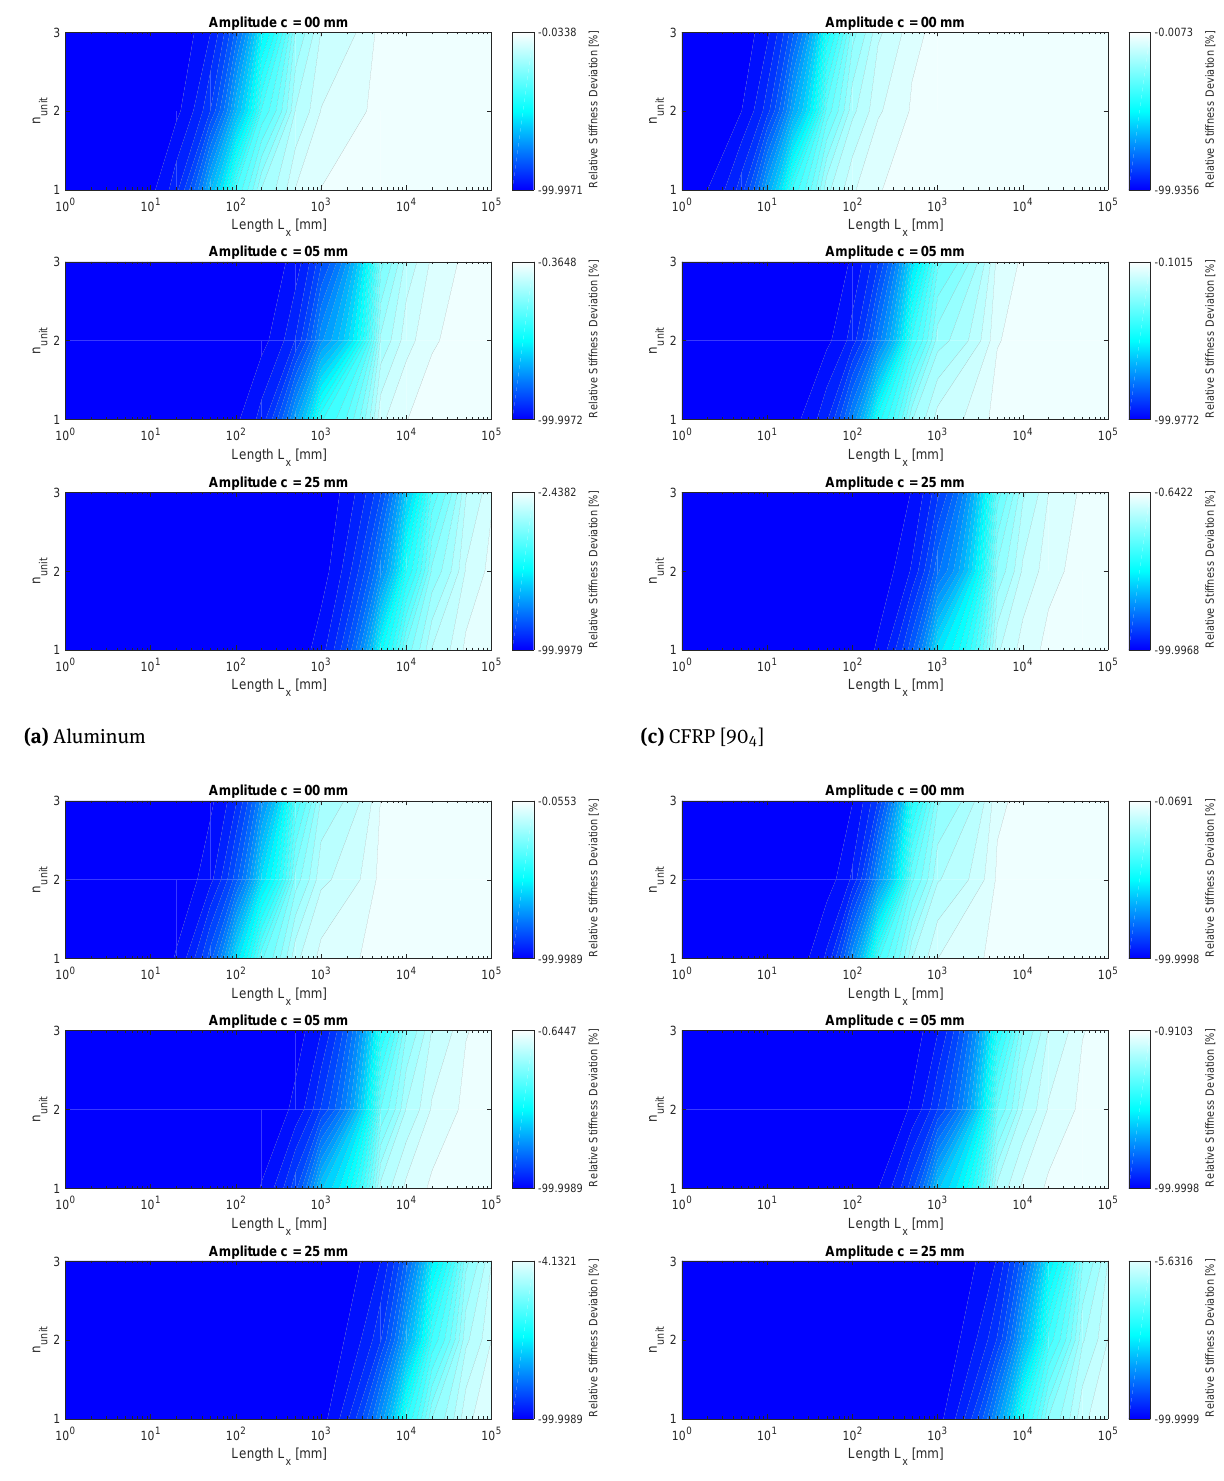
Figure 16: Load case 3 normalized apparent stiffnesses versus L x and n unit - for Aluminum and CFRP [0 4 ]